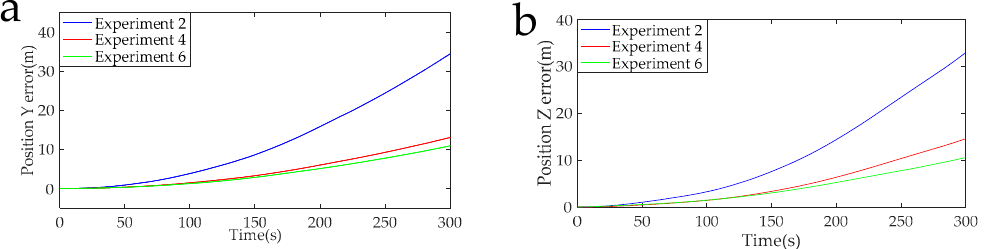
Figure 16. ( a ) Position Y error curves of the Experiments 2, 4, and 6. ( b ) Position Z error curves of the Experiments 2, 4, and 6.